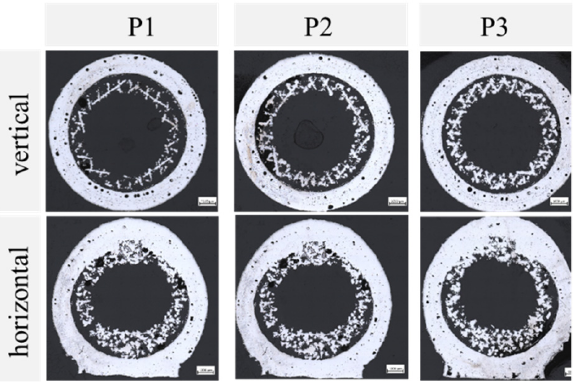
Figure 8. Optical microscopy images of porous wicks printed vertically ( top row ) and horizontally ( bottom row ) with porous process parameters P1 to P3.